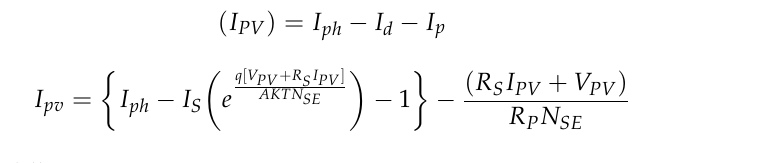
(cid:0) (cid:1) I p is the current across the (cid:16) (cid:17) , ( T ) is 1.38 × 10 − 23 J K